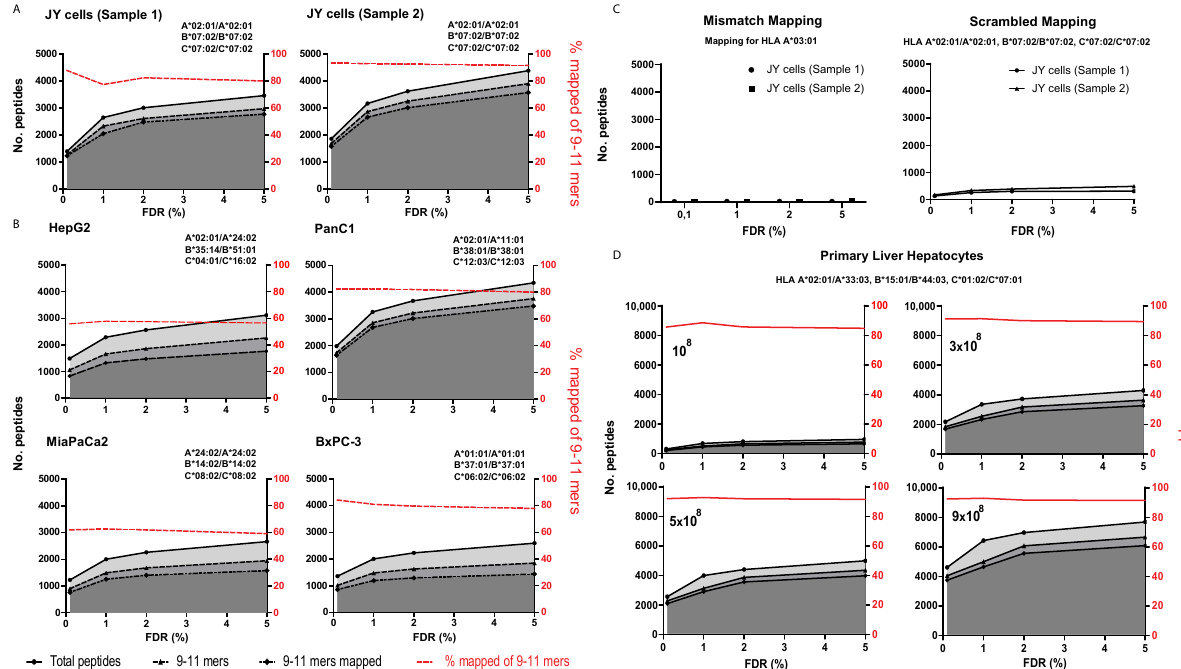
Figure 1. FDR score analysis for various cell lines and primary samples. ( A , B ) Obtained immunopeptidomes with the database search of ( A ) JY cells in duplicate and ( B ) various pancreatic and hepatic cancer cell lines. ( A , B , D ) Shades of grey (top-down) represent the total number of identified peptides, total number of 9–11 mers identified and the total number of 9–11 mers predicted to bind cell- expressed HLA at the indicated FDR (all left y -axis). The percentage of predicted HLA-binders of identified 9–11 mers peptides is indicated in red (% mapped on right y -axis). ( C ) The left graph shows predicted binding of HLA-derived 9–11 mers to the indicated irrelevant HLA types (mismatch binders) of two independent JY datasets. The right graph depicts the predicted binding of a scrambled peptide dataset containing peptides that are matched in number, length and amino acid composition to peptides derived from two independent JY HLA datasets across indicated FDR thresholds. ( D ) Immunopeptidome of various cell numbers of isolated primary hepatocytes ranked on cellular input from low to high (input number indicated in graph) from left to right and top to bottom. ( A – D ) The HLA types used for in silico prediction of HLA-binding are indicated above each